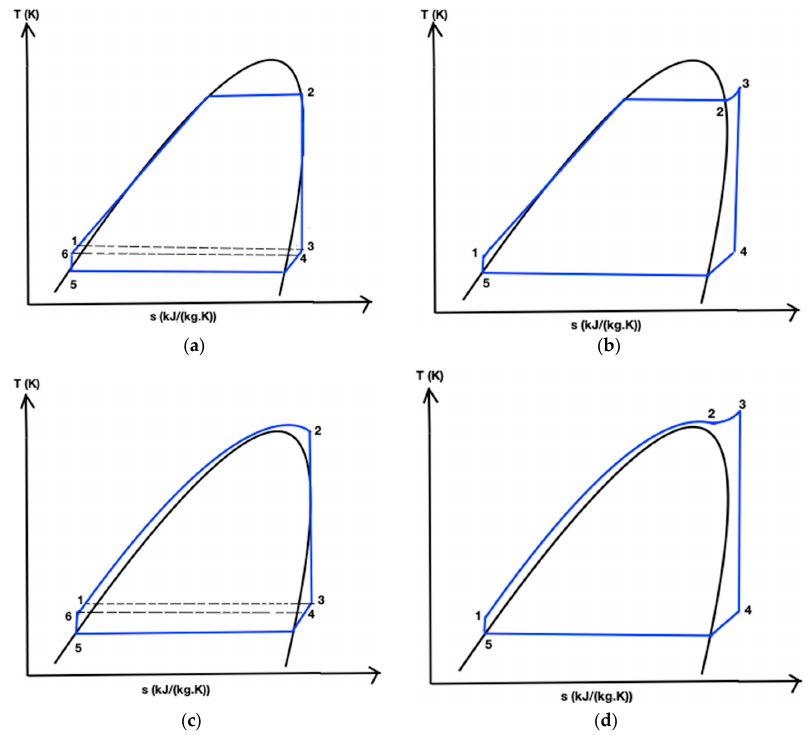
Figure 8. ( a ) T–s diagram for case A and ( b ) T–s diagram for case B. ( c ) T–s diagram for case C and ( d ) T–s diagram for case D.